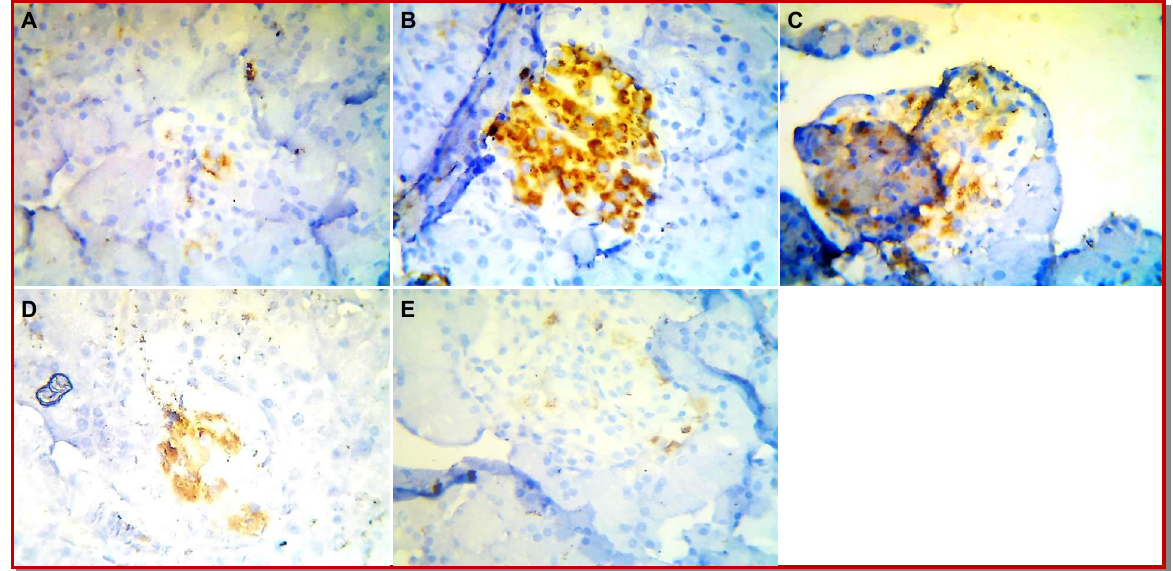
Figure 2: Insulin expressions of treated animal pancreas in immunohistochemistry study. (A) Diabetic control rat; (B) Normal control rat; (C) Glibenclamide treated; (D) A. alnifolia acetone extract treated; (E) A. alnifolia methanol extract